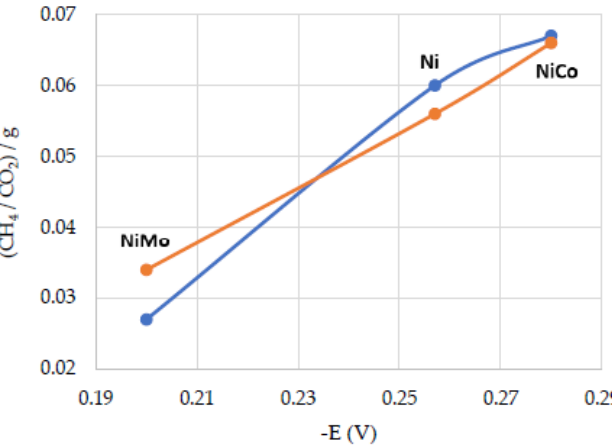
Figure 2. The dependence of the catalyst efficiency on the standard reduction potential of the influencing catalytic metal. Blue line—initial biomass: birch shavings; red line—initial biomass: ground apricot stones.